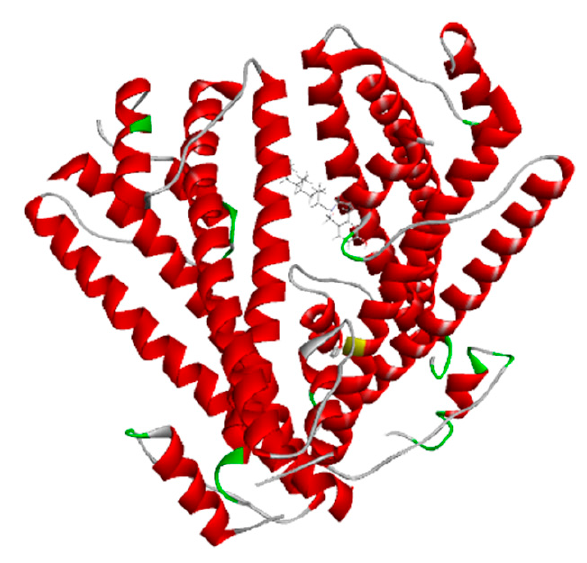
Figure 10. The docked complex of AIGT and BCR-ABL1 from Patchdock .